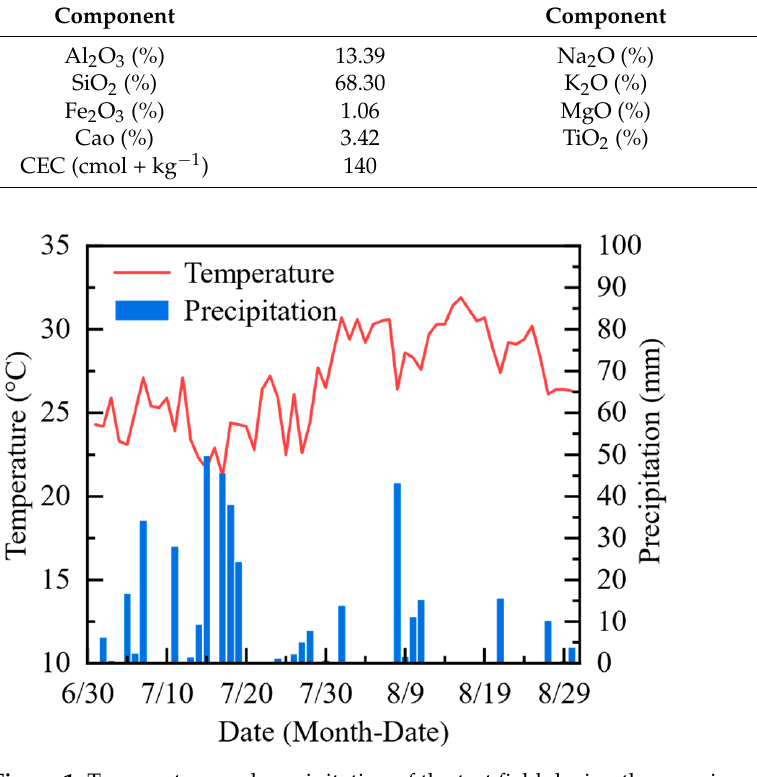
Figure 1. Temperature and precipitation of the test field during the growing season. Table 1. Chemical composition of the clinoptilolite zeolite.